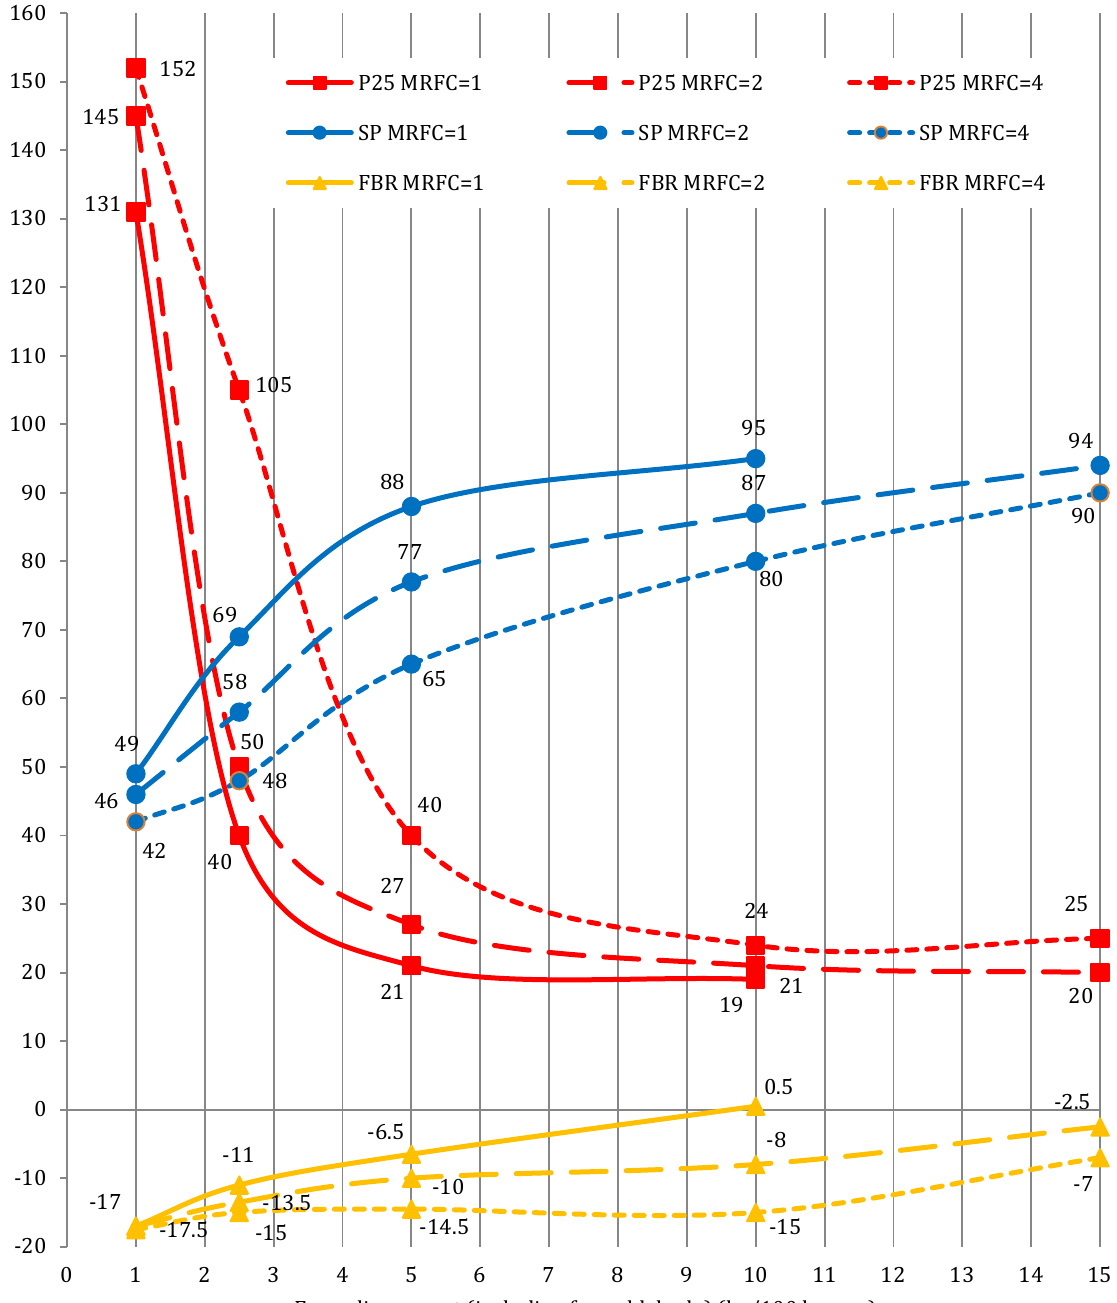
Figure 11. The effect of MRFC on the modification process: raw is T1; catalyst H 2 SO 4 ; temperature 100 °C; duration 0.5 h .